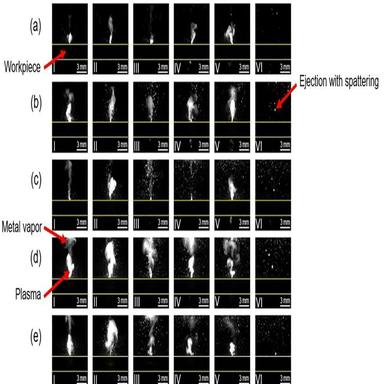
High-speed camera images showing the transient evolution of the through-hole drilling stage using the third laser pulse under different ultrasonic powers of (a) 0 W, (b) 156 W, (c) 311 W, (d) 467 W and (e) 622 W.